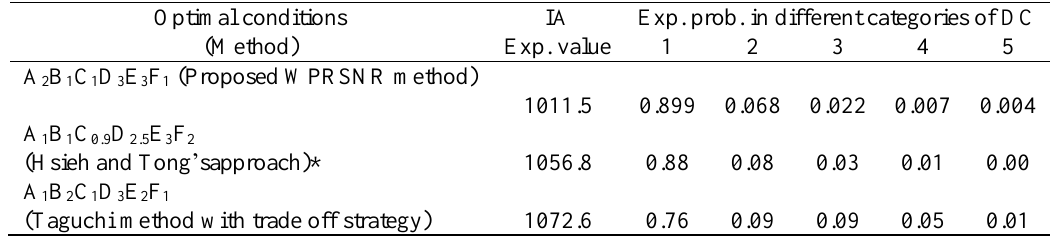
Table 7. Expected values of measures at different optimal process conditions.